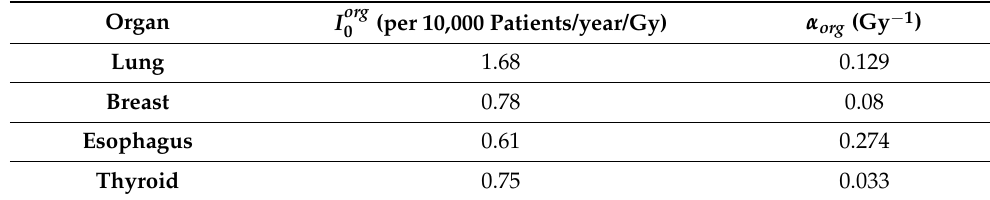
and sterilization parameter α org for 0